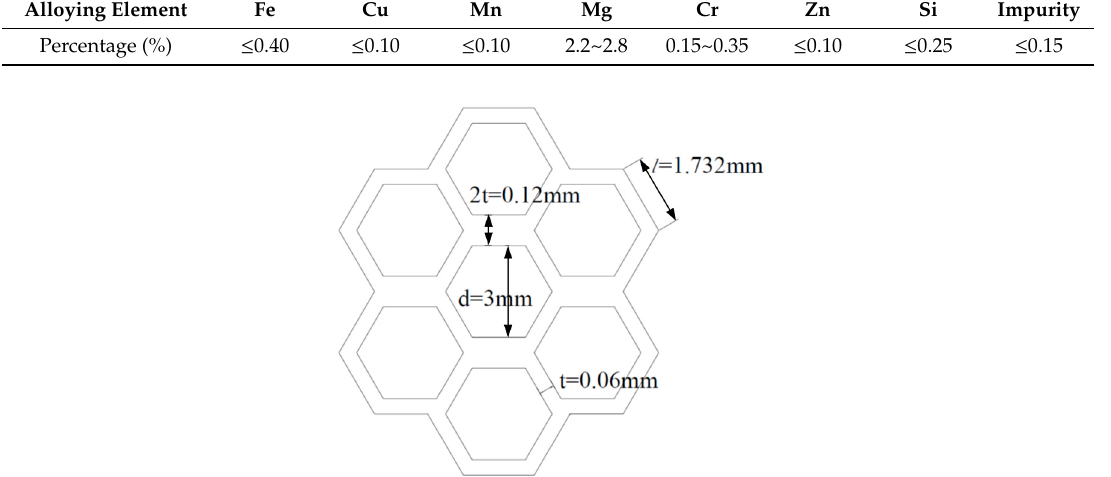
Figure 2. Coordinate system of aluminum honeycomb structure. 2.2. The Special Measures of Split Hopkinson Pressure Bar (SHPB) Test Method and Verification The SHPB method is widely used in dynamic compression tests for metal materials to obtain the dynamic mechanical properties. However, there are still many difficulties when it is applied to the honeycomb structure, especially at the high strain rate, which are mentioned before. The following special measures are taken to overcome the difficulties. The actual impact area of the honeycomb structure is small compared to metallic materials due to the thin cell wall during the impact, which may cause the stress nonuniformity of the specimen and the divergence of the stress wave. The specimen of Φ 32 is applied to reduce the stress nonuniformity and the divergence of the stress wave as well as the diameter of the incident bar is 37 mm. The specimen contains nine complete cells in the direction of diameter. Try to maintain the integrity of cells at the edge of the specimen during the processing. The wave impedance of the honeycomb structure is lower than that of aluminum alloy bar which makes the weak signal in the transmission bar. The semiconductor strain gauge is applied on the transmission bar to acquire the nice waveform of the weak signal, which cannot be measured by the conventional resistance strain gauge. It is also more convenient than the adoption of the viscoelastic bar. The contact surface between the bar and the specimen is lubricated to reduce the friction between the end face of the specimen, the incident bar as well as the transmission bar. The loads between the impact end and the support end of the specimen may be different due to the divergent oscillation of incident wave, resulting in poor stress uniformity inside the specimen. Therefore, the brass wafer is pasted at the impacted end of the incident bar to eliminate the unbalanced stress caused by the divergence of the stress wave. The short specimen and long impact bar are employed to make the stress wave passing through at least 3–4 reflections in the specimen, realizing the homogenization of the stress in the specimen. The measurements based on the SHPB method are shown in Figure 3.